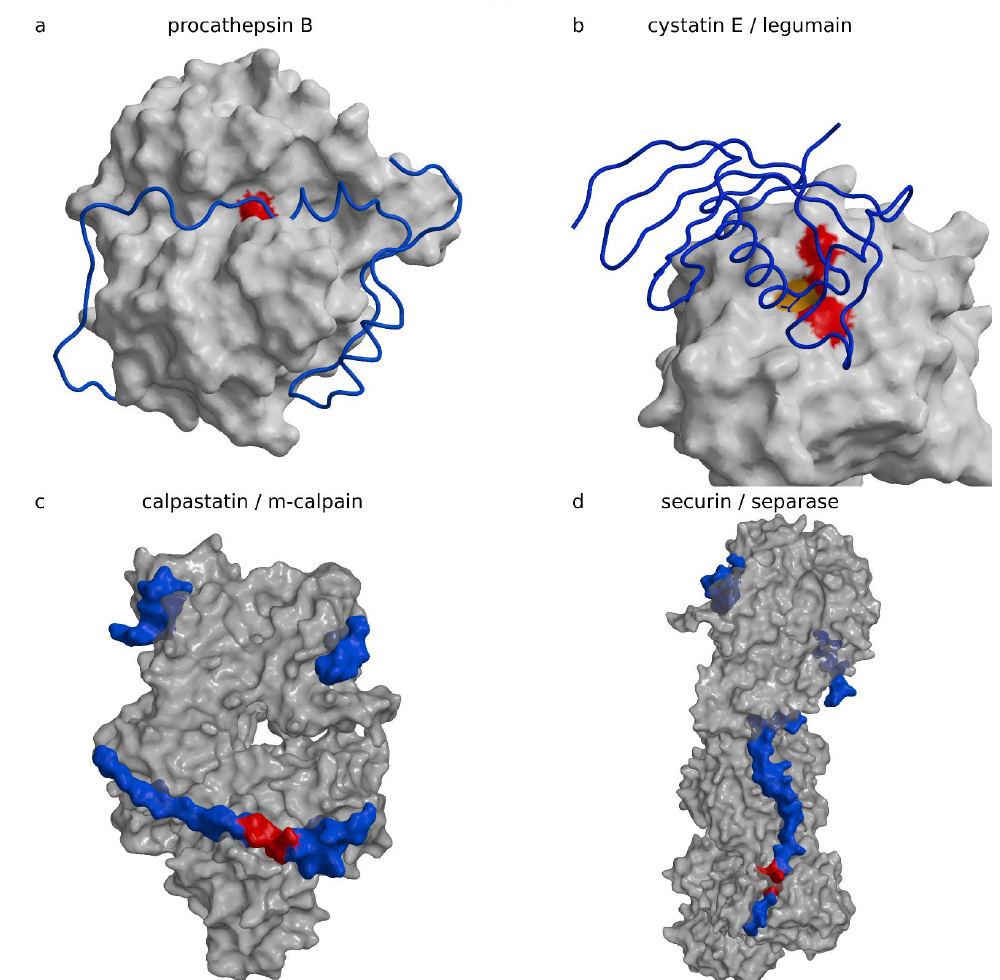
Figure 3. Other inhibitors. Complexes of inhibitors are shown in views and scales adjusted to each complex and size. Figure was prepared using MAIN [82] and rendered with Raster3d [36]. ( a ) Procathepsin B ([98], PDB code 3PBH). The chain of cathepsin B propeptide is shown as a blue coil on the white surface of mature enzyme part of the structure. The surface part corresponding to the catalytic pair of C29 H199 residues is colored red. ( b ) Cystain E legumain complex ([41], PDB code 4N6N). Cystatin E is shown as a blue ribbon, with the P1 residue N39 side chain bound in to the legumain S1 site shown as a red stick model. Legumain is shown as a white surface with the S1 binding pocket colored orange and the part corresponding to the reactive site residues C189 H148 colored red. ( c ) Calpastatin m-calpain complex ([99], PDB code 3DF0). Calpastatin is shown as a blue surface with the loop out region indicating the position above the reactive site of calpain shown in red. Calpain-m is shown as a semitransparent white surface. ( d ) Securin separase complex ([100], PDB code 5ULS, 5ULT). Securin is shown as a blue surface with the region from 262 to 265 bound above the reactive site of separase shown in red. Securin is shown as a semitransparent white surface.